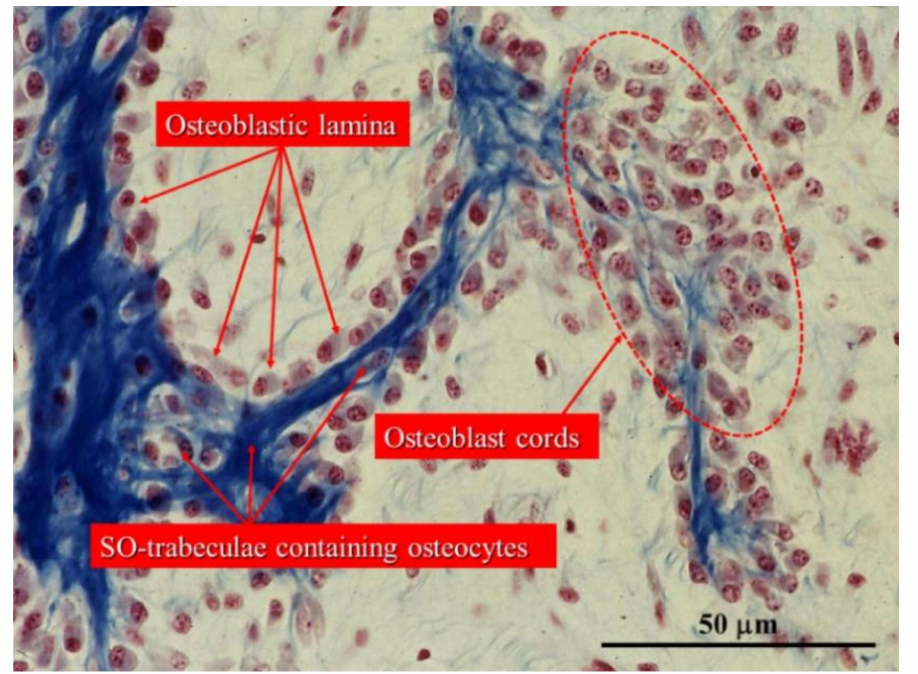
Figure 6. Histological section of an intramembranous ossification center showing a cord of stationary osteoblasts (red circles) and osteoblastic laminae on the surfaces of pre-existing bone containing SO osteocytes. (Light microscope photo from new-born rabbit calvaria).